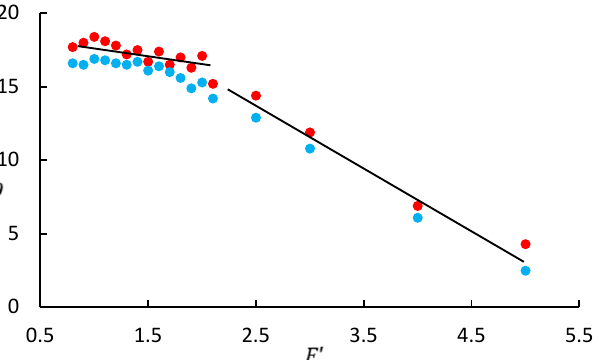
Figure 8. A plot of apparent wake angle 𝜃 against Froude number 𝐹′ for a flow past the Rankine source, with the source strength µ (cid:48) = 1.0 (the red circles) and µ (cid:48) = 0.5 (the blue circles). The black solid lines are the trendlines of the wake angles with Froude numbers.